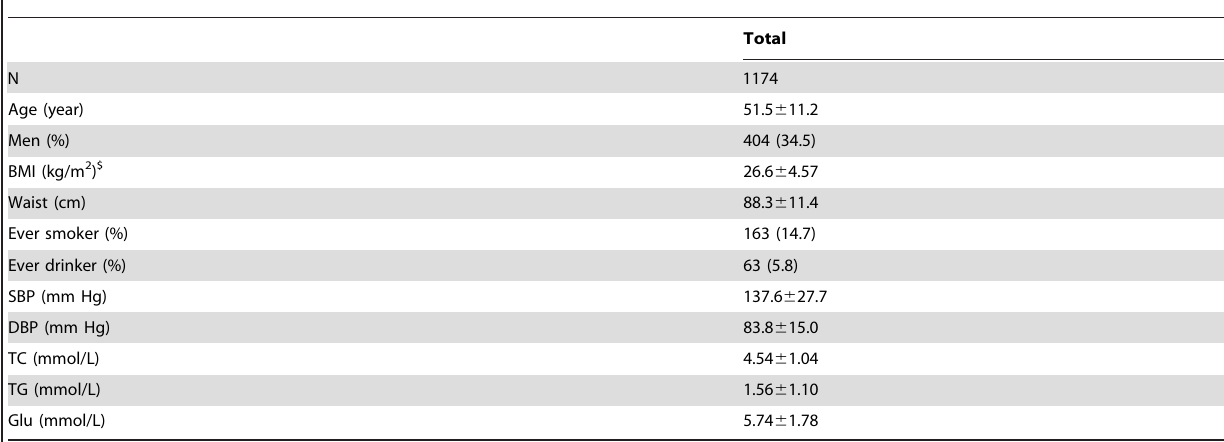
Table 1. Clinical characteristics of the studied subjects.